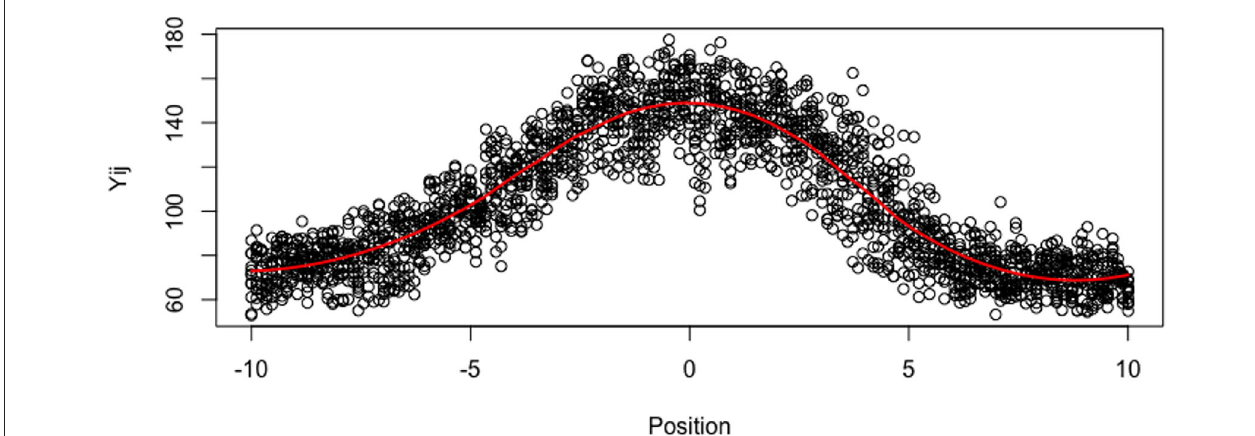
FIGURE 3 | Imputated Data ˜ y ij for all tubes at all locations. The red line is loess smoother.